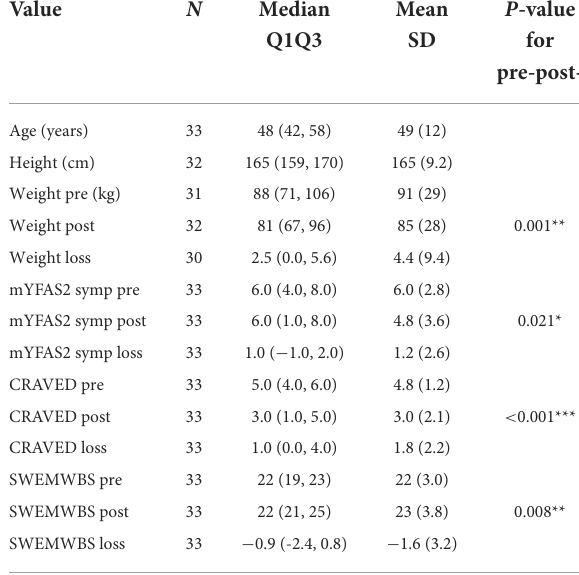
TABLE 4 Summary data for SE participants.